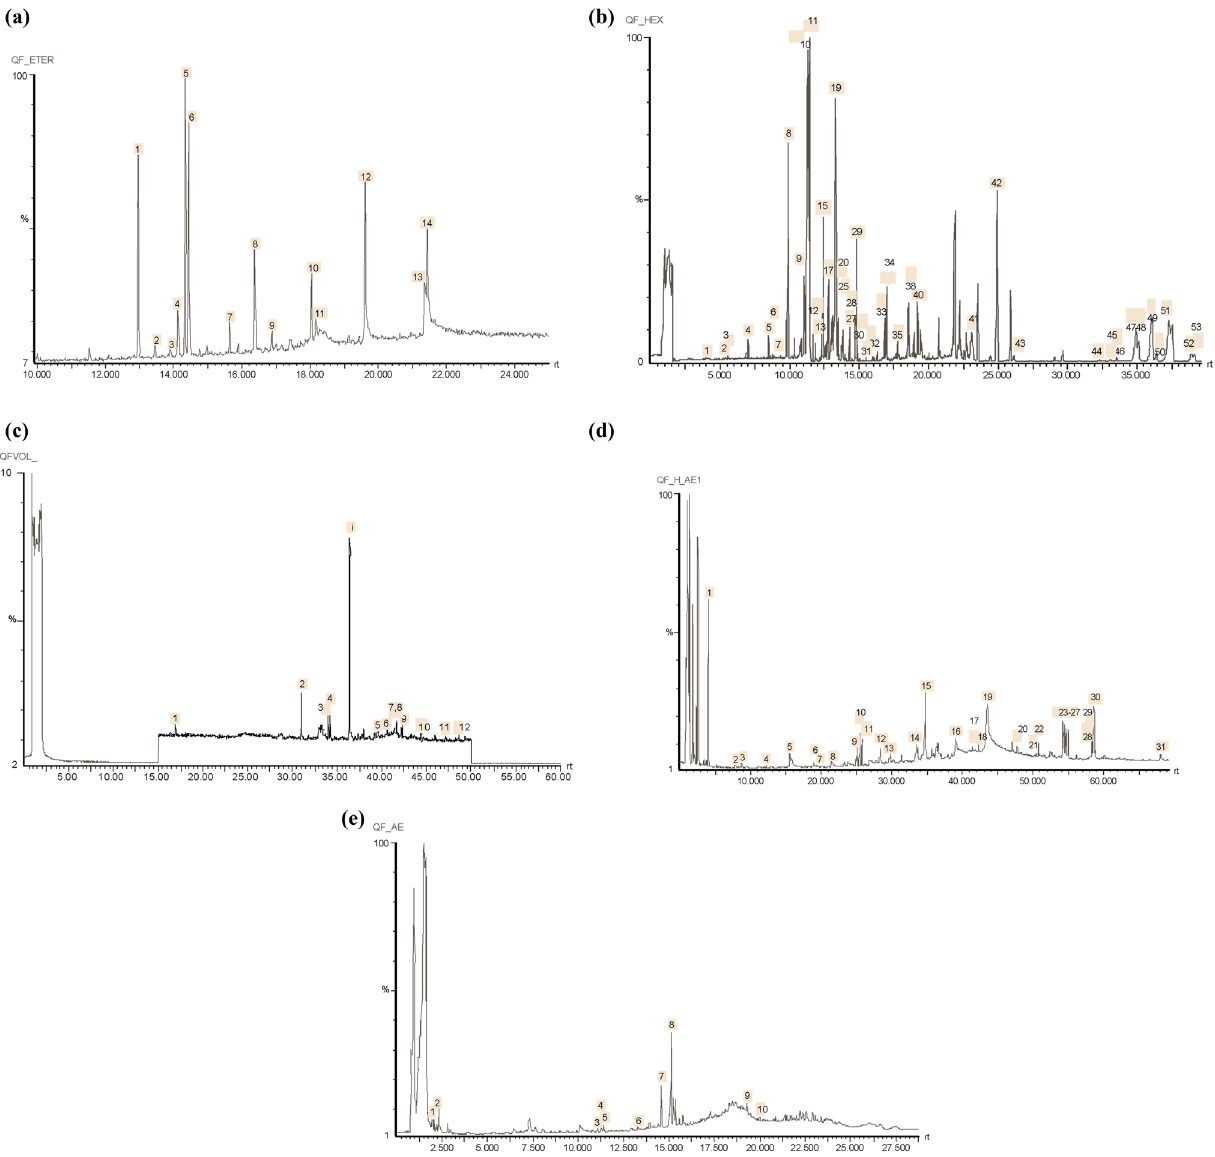
Figure 1: Gas chromatograms ( FID ) of mango stem bark extracts, Haden variety. ( a ) Fresh mango stem bark extract by Soxhlet extraction. ( b ) Industrial spray - dried mango stem bark extract ( MSBE ) by simultaneous steam distillation - solvent extraction. ( c ) Hexane eluate by preparative chromatography from extract A. ( d ) Hexane – ethyl acetate ( 1:1 ) eluate by preparative chromatography from extract A. ( e ) Ethyl acetate eluate by preparative chromatography from extract